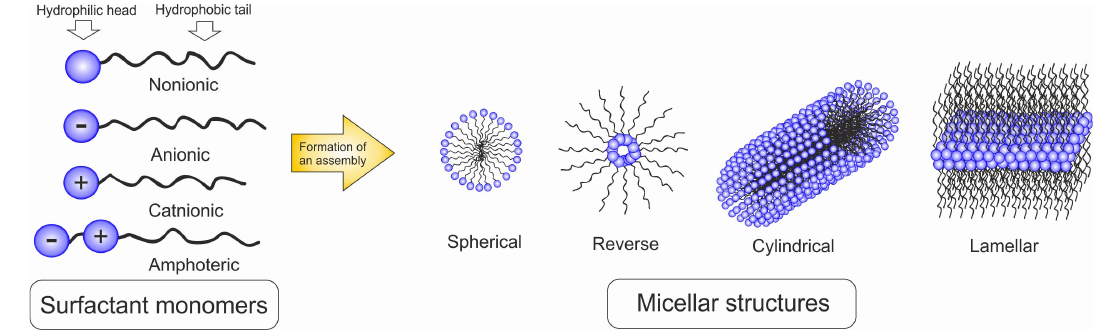
Figure 10. Types of surfactants and micellar